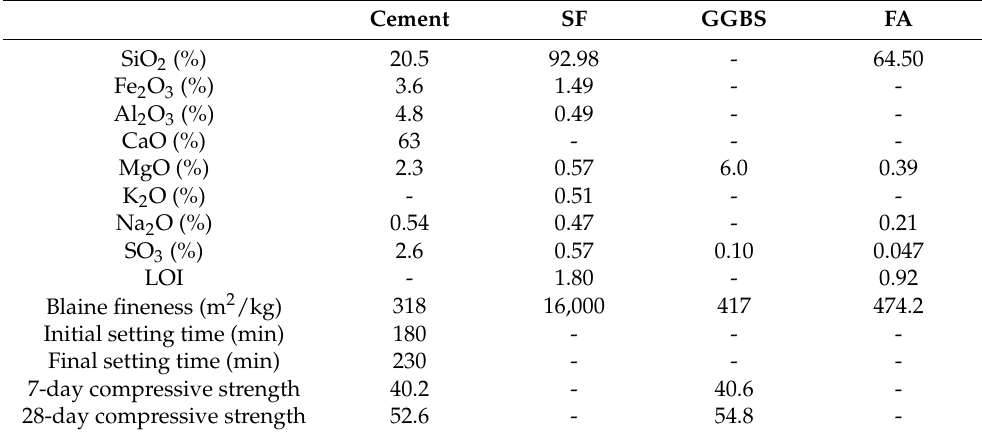
Figure 2. Steel fibers. Table 1. Chemical composition and physical properties of different binder